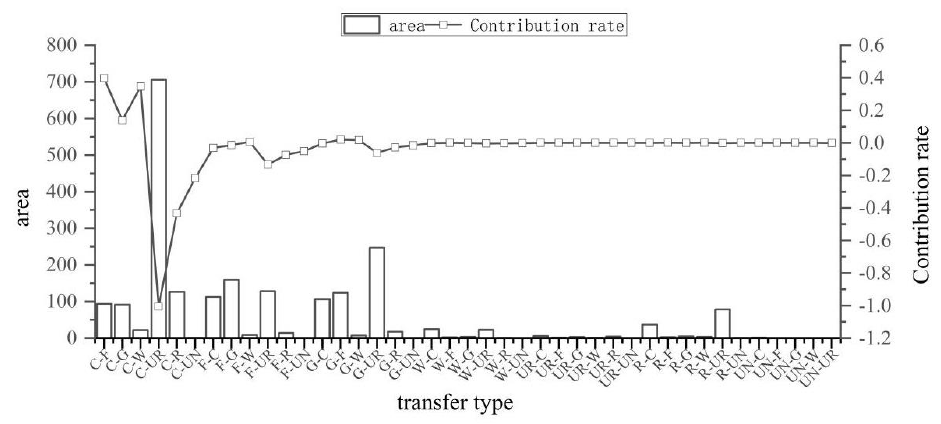
Figure 10. Contribution of various types of land use changes in ecosystem health deterioration areas. C (cultivated land), F (forest land), G (grassland), W (water area), UR (urban land), R (rural land), UN (unutilized land).